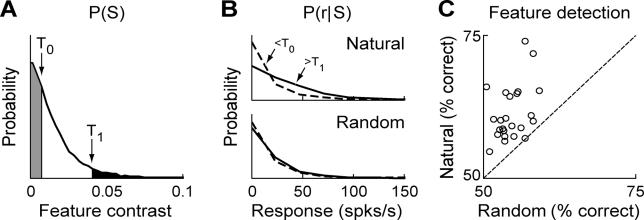
Detectability of Features from Neuronal Responses to Natural Images and Random Stimuli(A) Probability distribution of feature contrast in a natural ensemble (or, equivalently, its matched random ensemble). For simplicity, only the positive side (feature contrast >0) is shown. Gray shading: feature contrasts near zero (<T
0, here T
0
= 0.007, “feature absent”); black shading: high feature contrasts (>T
1, here T
1 = 0.04, “feature present”).(B) Conditional probability distributions of responses evoked by natural images (upper) and random stimuli (lower). Solid lines: response distributions when the feature was present in stimulus (black shading in [A]); dashed lines: distributions when the feature was absent (gray shading in [A]).(C) Feature detectability in natural images versus that in matched random stimuli, for the same population of cells shown in Figure 3B. Detectability was measured as the percentage of trials in which stimuli were correctly classified as “feature present” or “feature absent” (see Materials and Methods).